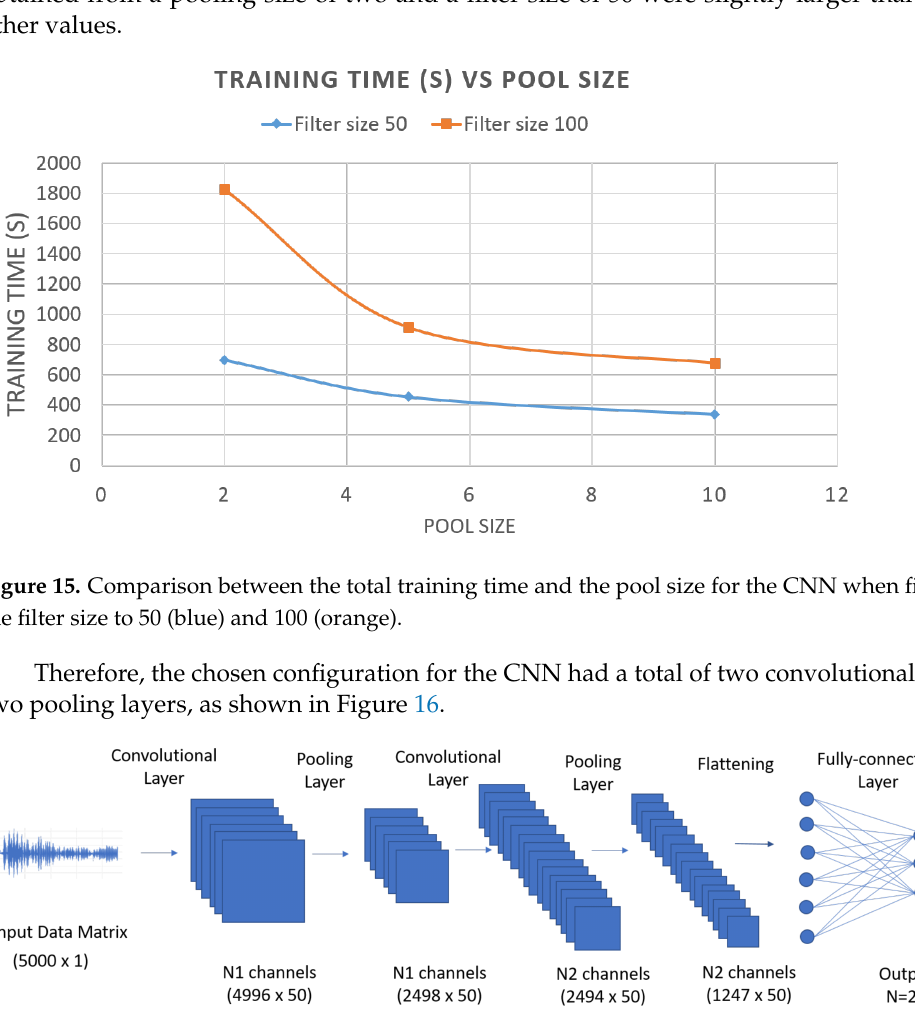
Figure 16. Chosen architecture for the CNN, with two convolutional and two pooling layers with the total size of each layer represented under the graphical